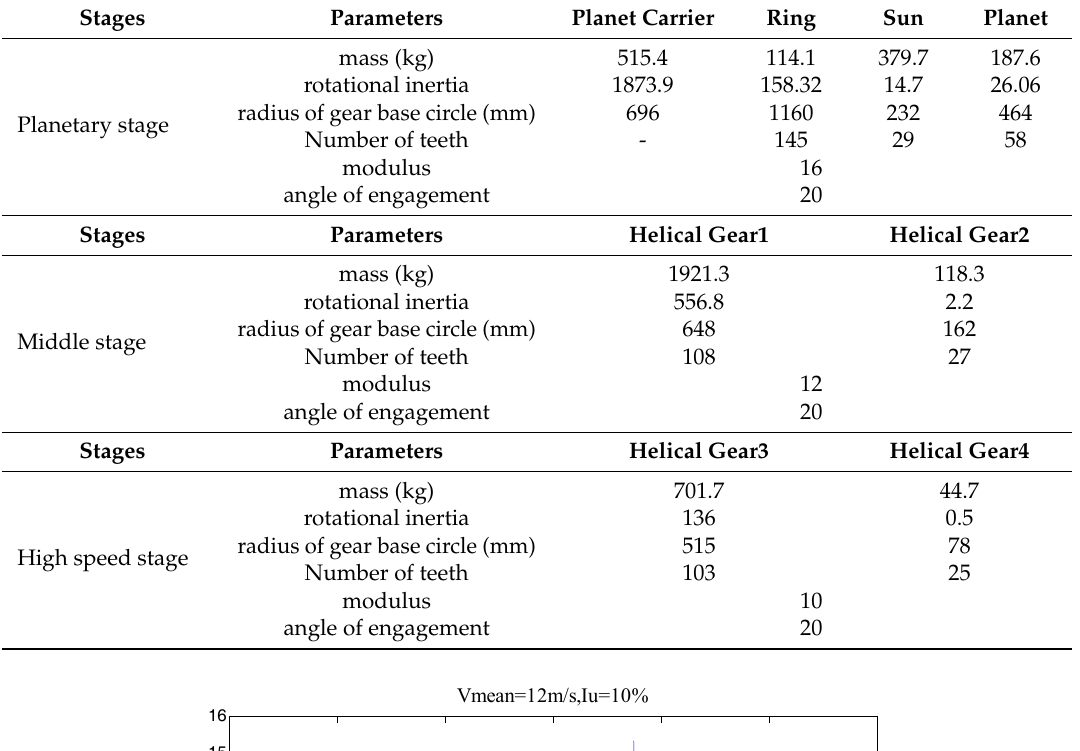
Table 2. Gearbox’s geometry parameters.